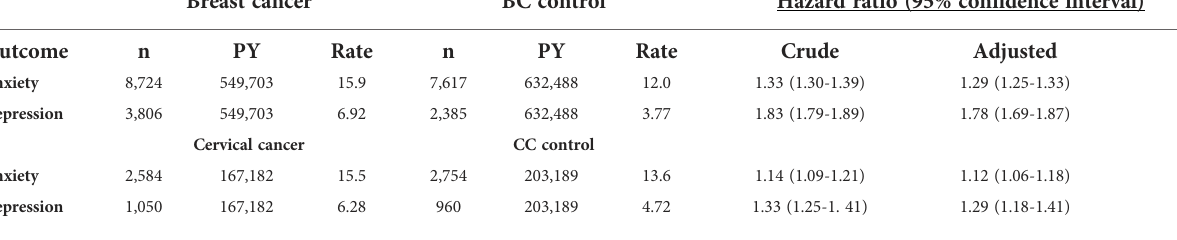
TABLE 2 Incidence rates of anxiety and depression and cancer cohort to comparisons hazard